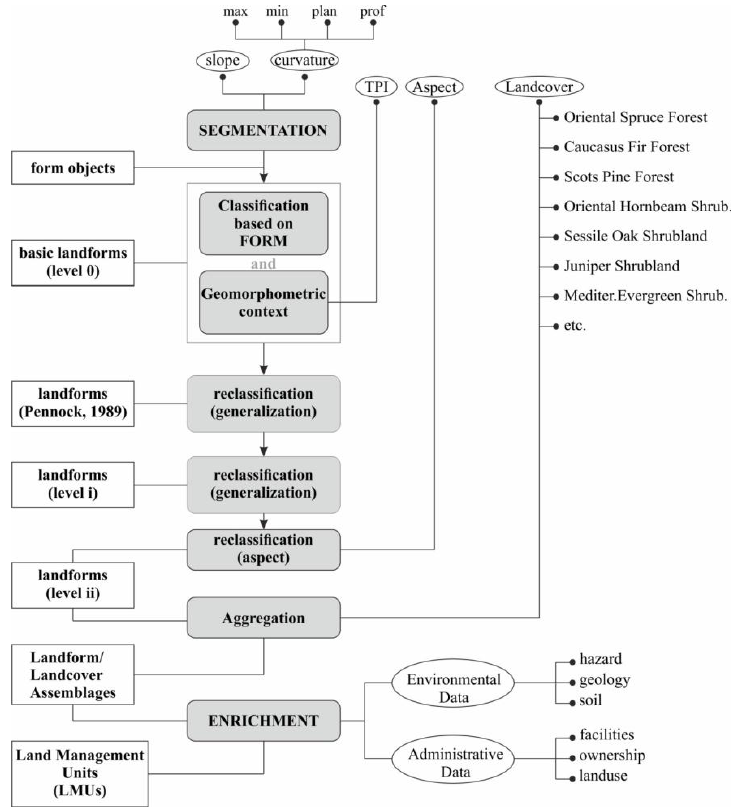
Figure 2. Flowchart of the method.